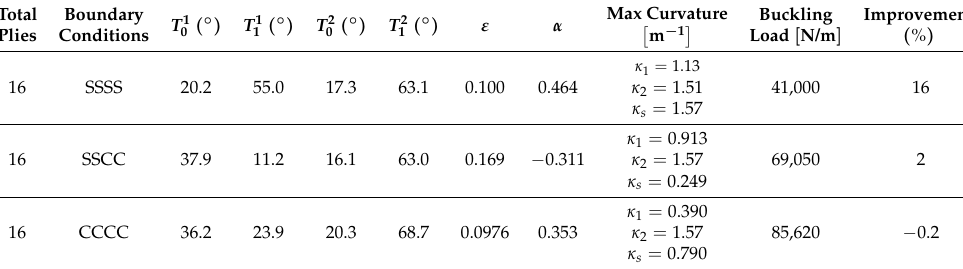
Table 7. Optimization results of ideal panels subjected to biaxial compression plus shear